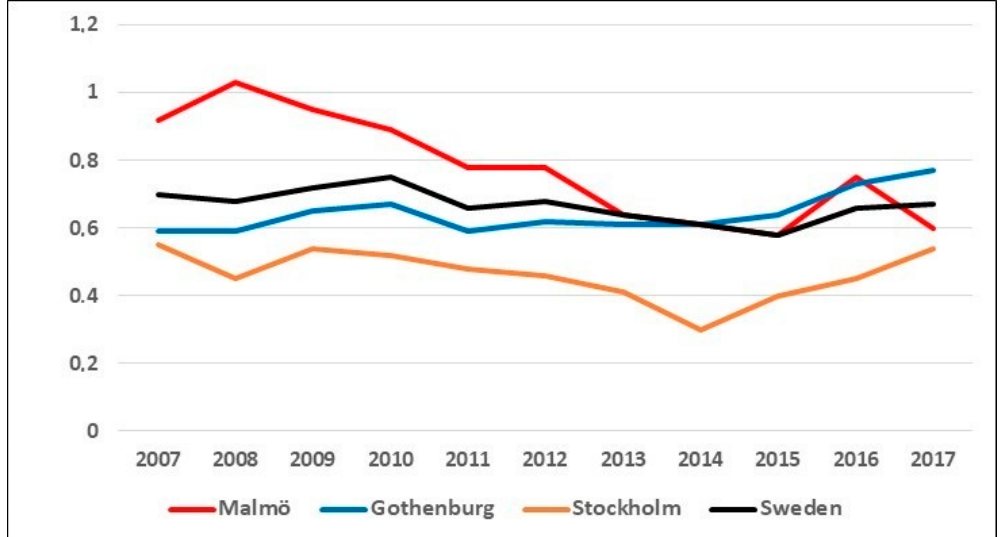
Figure 1. Residential fires per 1000 inhabitants in Sweden and the three largest metropolitan areas 2007–2017.